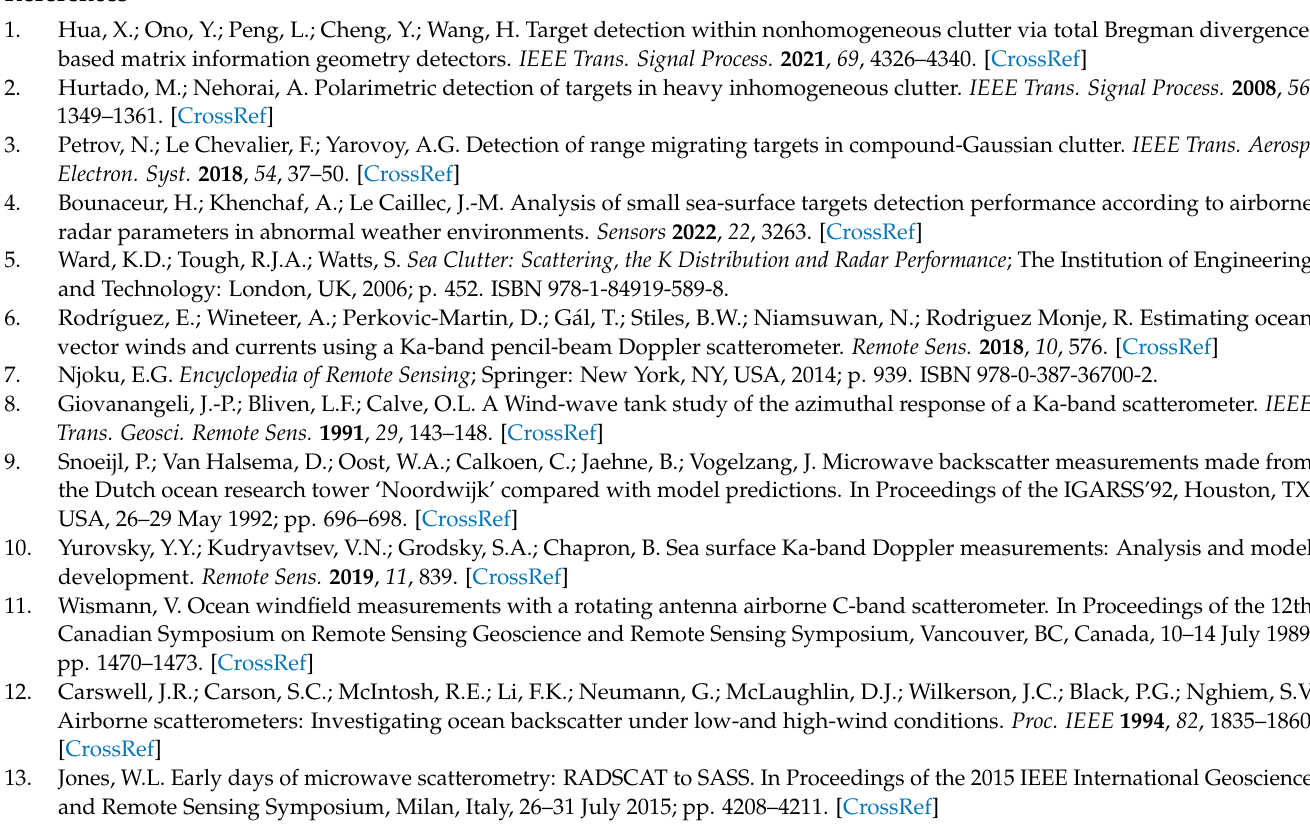
Figure A24. Simulation results of the use of three incidence angles of 30 ◦ , 45 ◦ , and 60 ◦ for wind retrieval.